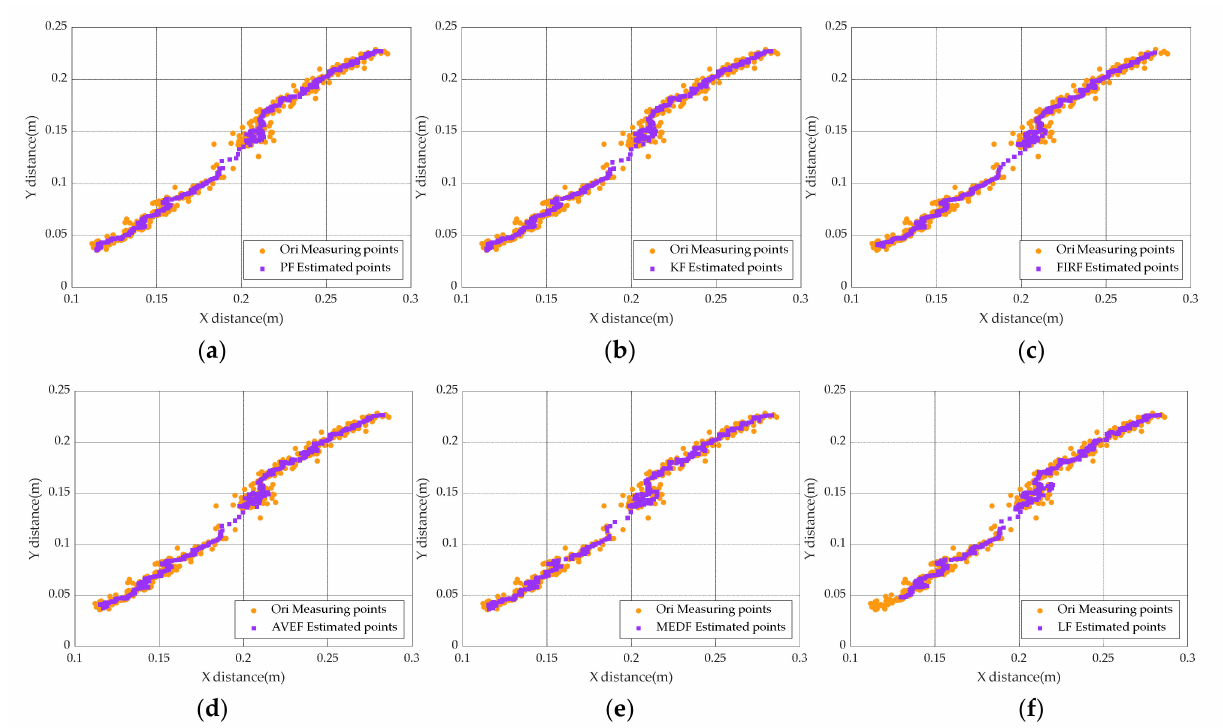
Figure 12. Comparison of the filter effect of different filters under nonlinear conditions in the two-dimensional plane: ( a ) is the effect of PF in the two-dimensional plane; ( b ) is the effect of KF in the two-dimensional plane; ( c ) is the effect of FIRF in the two-dimensional plane; ( d ) is the effect of AVEF in the two-dimensional plane; ( e ) is the effect of MEDF in the two-dimensional plane; ( f ) is the effect of LF in the two-dimensional